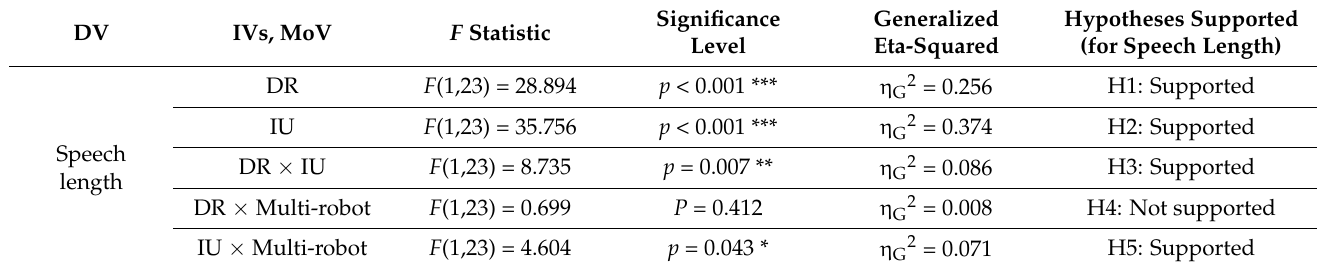
Table 4. ANOVA results for speech length.